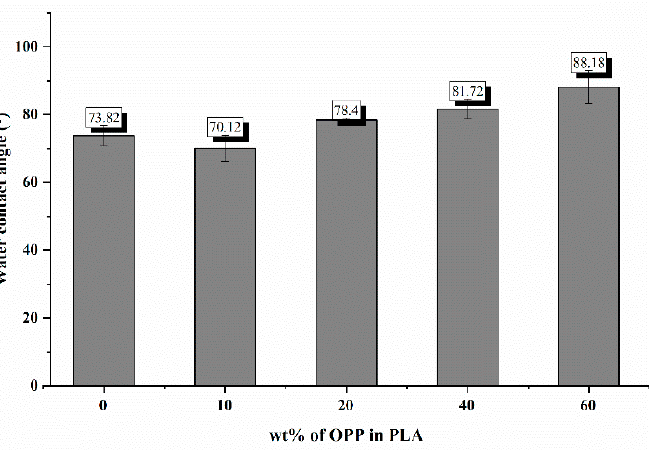
Figure 3. Water contact angle of PLA, PLA/10 wt%, PLA/20 wt%, PLA/40 wt%, and PLA/60 wt% OPP composites.